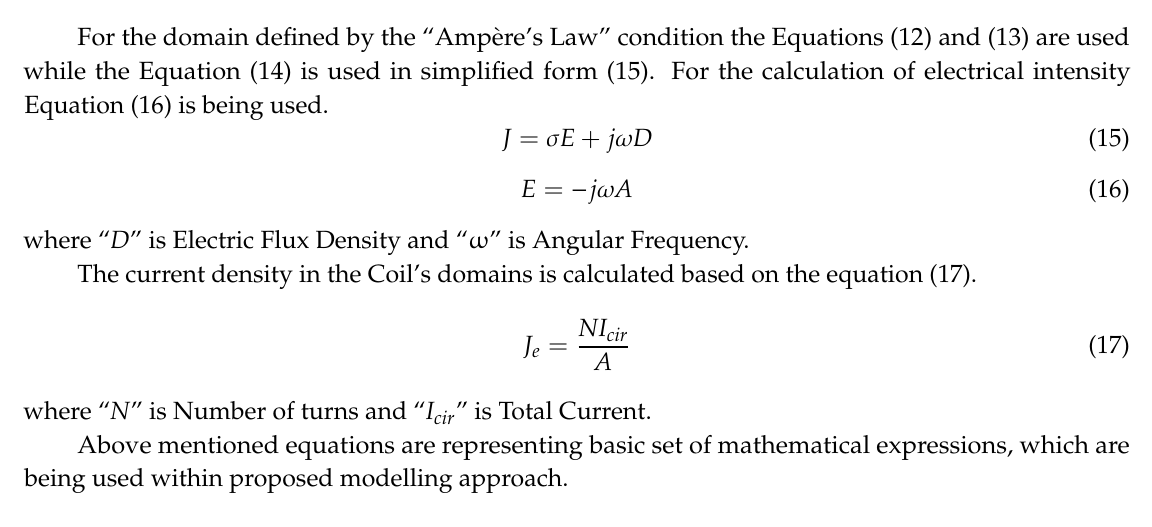
Table 1. Domains settings and boundary conditions